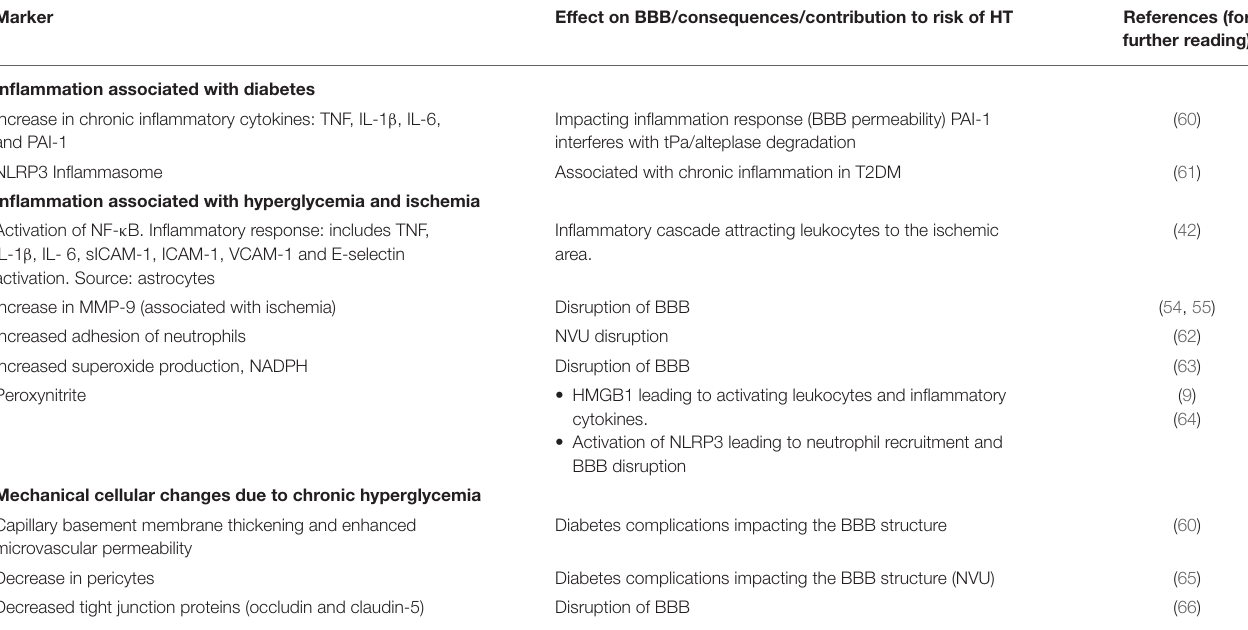
TABLE 5 | Summary of factors in hyperglycemia that promote BBB disruption and risk of HT.